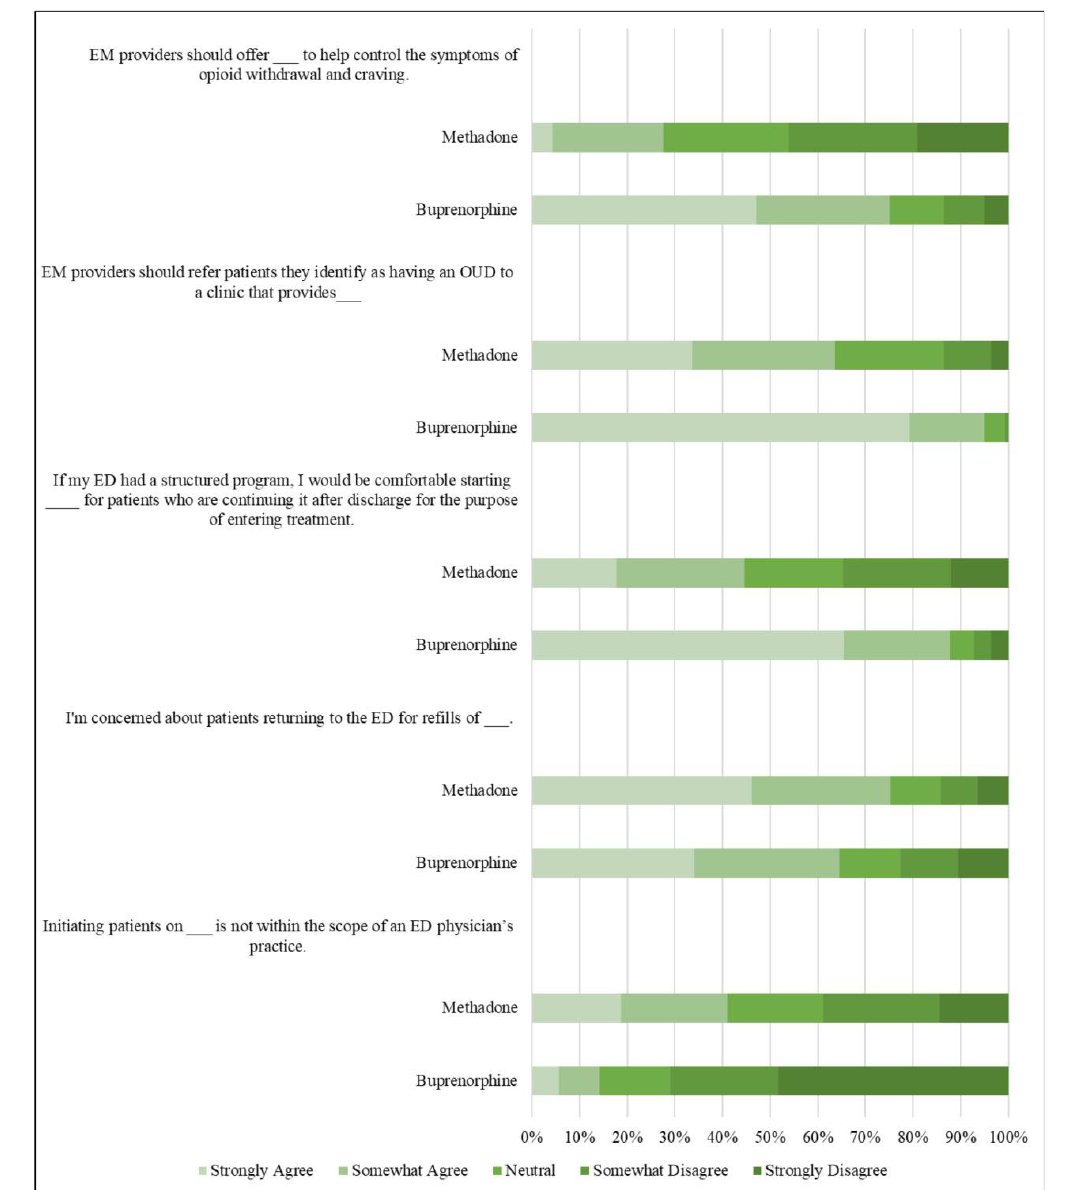
Figure 1. Perceptions questions on buprenorphine and